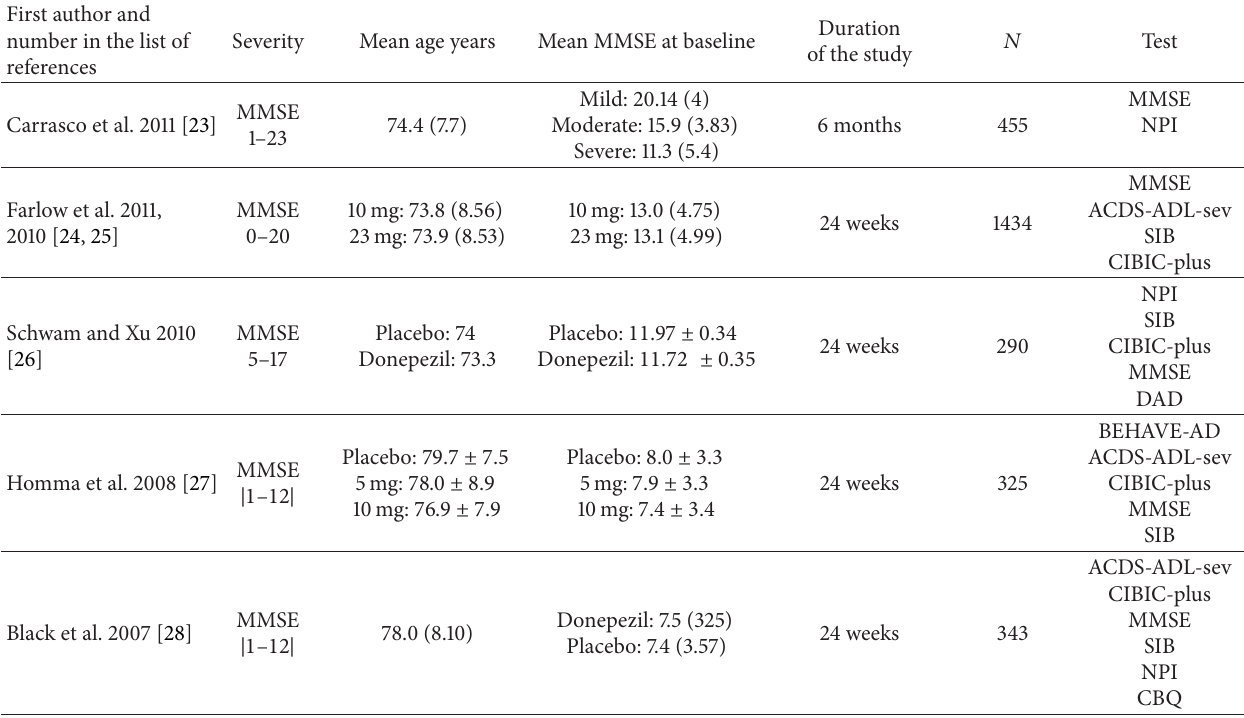
Table 4: Clinical trials on treatment with donepezil in moderate-severe AD.